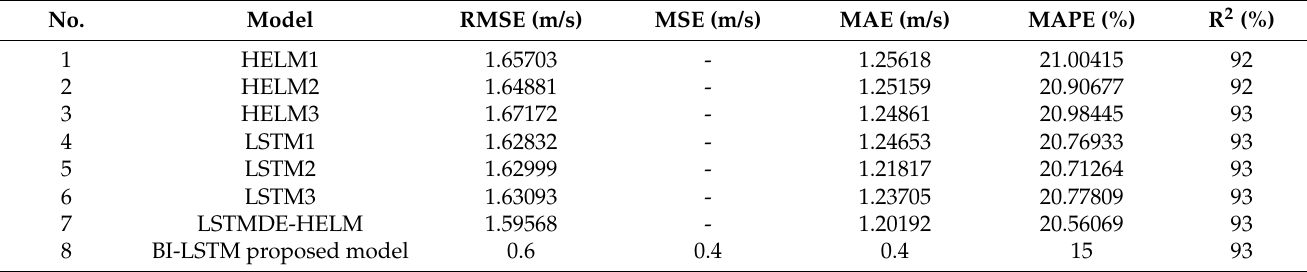
Table 4. Comparison of BI-LSTM proposed model performance with other wind speed models [16]. Copyright © 2021 Elsevier. No.